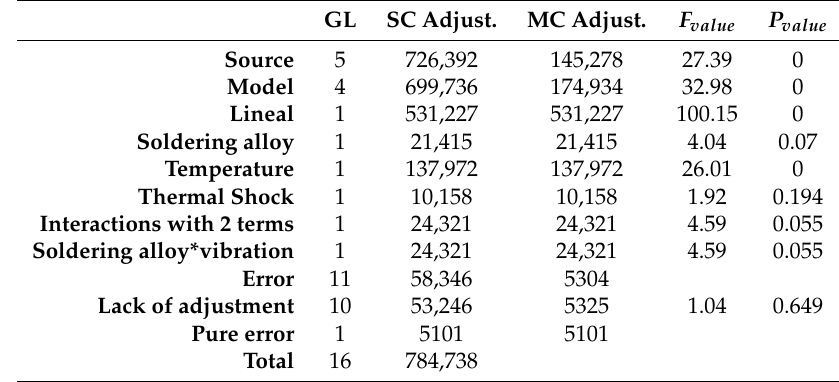
Table 2. Factorial Regression: Failure Time vs. Soldering Alloy, Path, Temperature, Thermal Shock, Vibration. GL SC Adjust. MC Adjust.